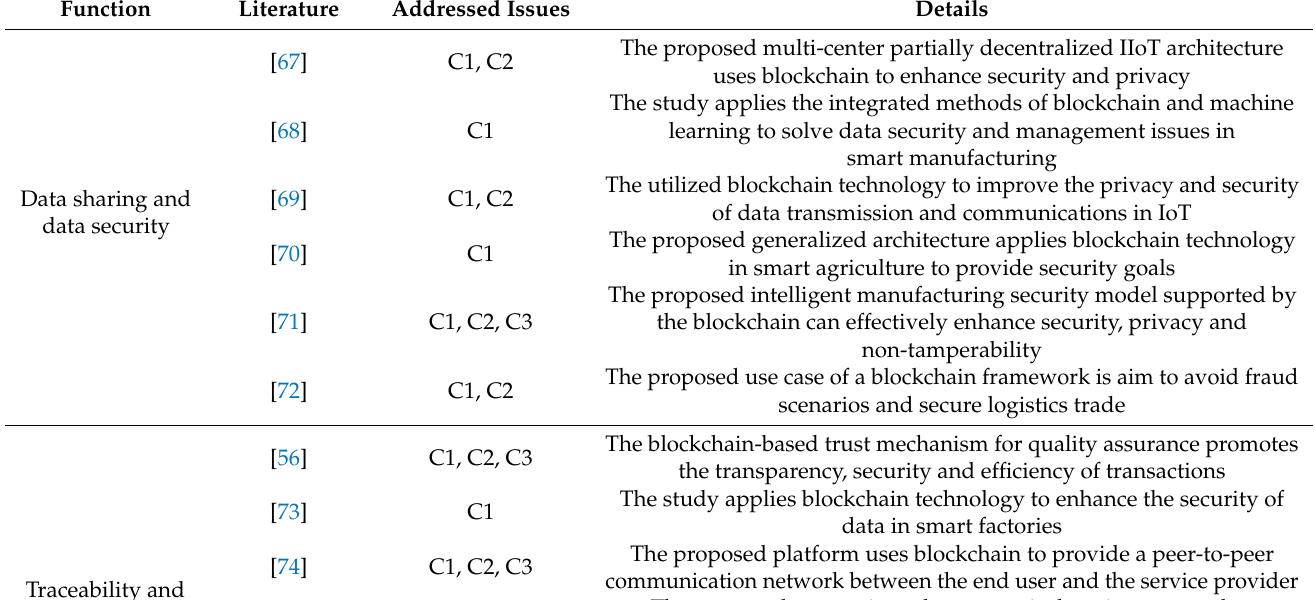
Table 2. Research on the application of blockchain technologies in smart